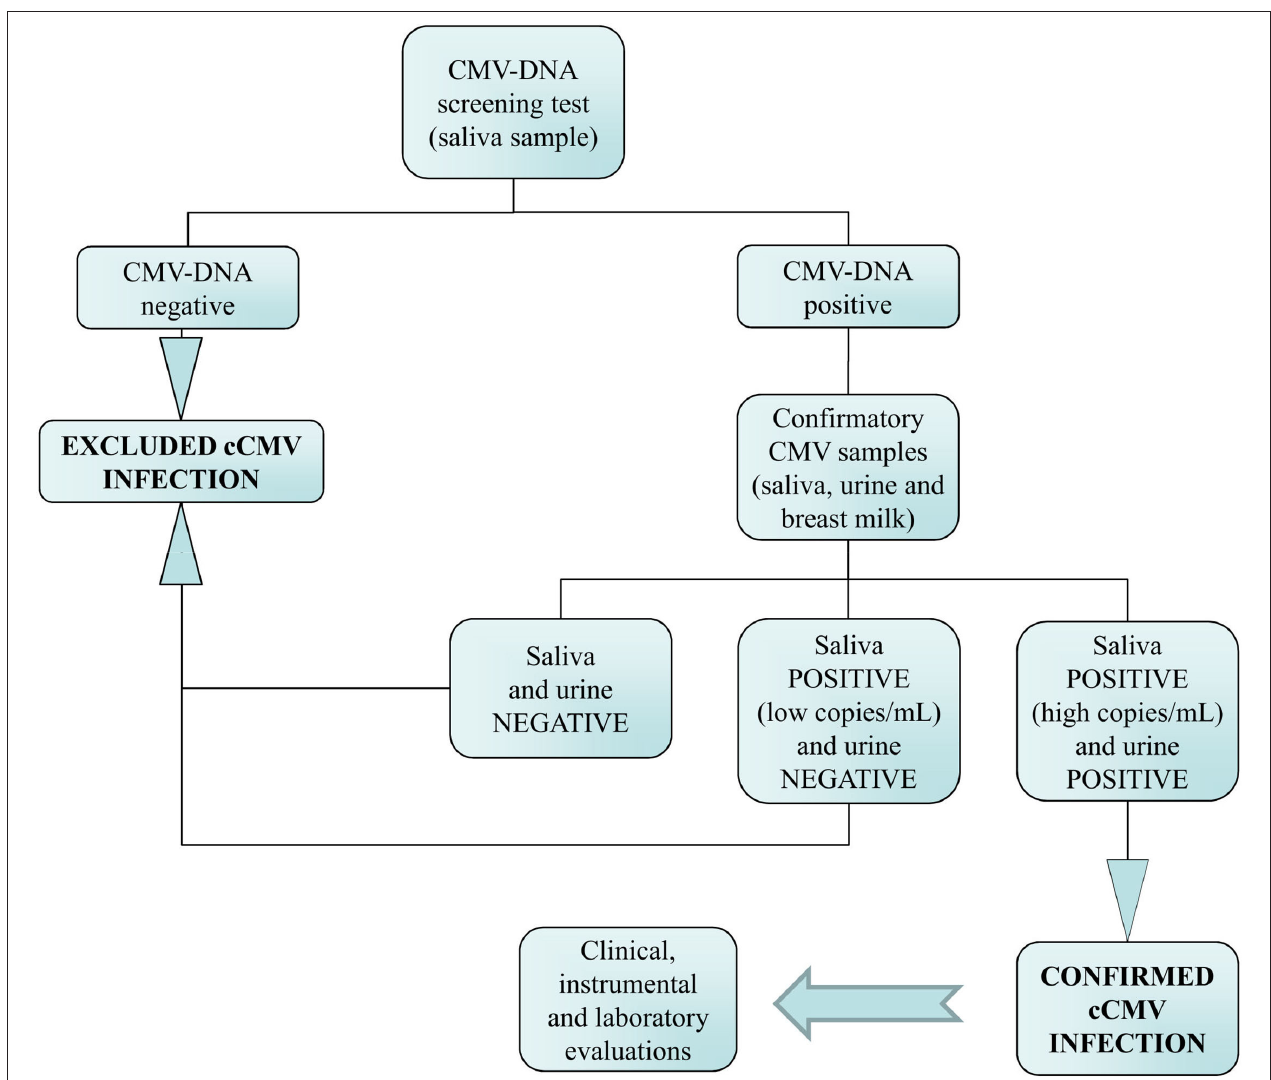
FIGURE 1 | Flowchart of the neonatal congenital CMV (cCMV) screening and the algorithm used for the diagnosis of